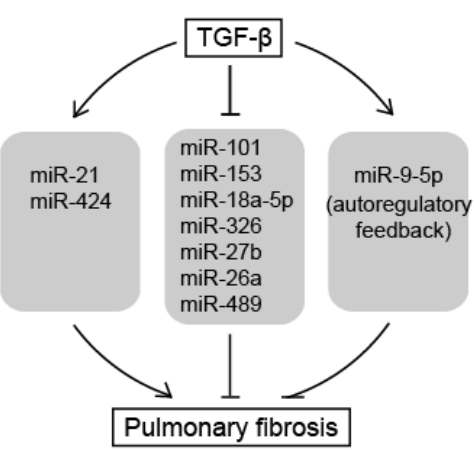
Figure 2. miRNAs as downstream effectors of TGF- β signaling in pulmonary fibrosis. TGF- β amplifies TGF- β signals by repressing anti-fibrotic miRNAs as well as inducing pro-fibrotic miRNAs, resulting in pulmonary fibrosis. Normal arrows represent upregulation of miRNA expression or promotion of pulmonary fibrosis. T-bar arrows represent downregulation of miRNA expression or inhibition of pulmonary fibrosis.